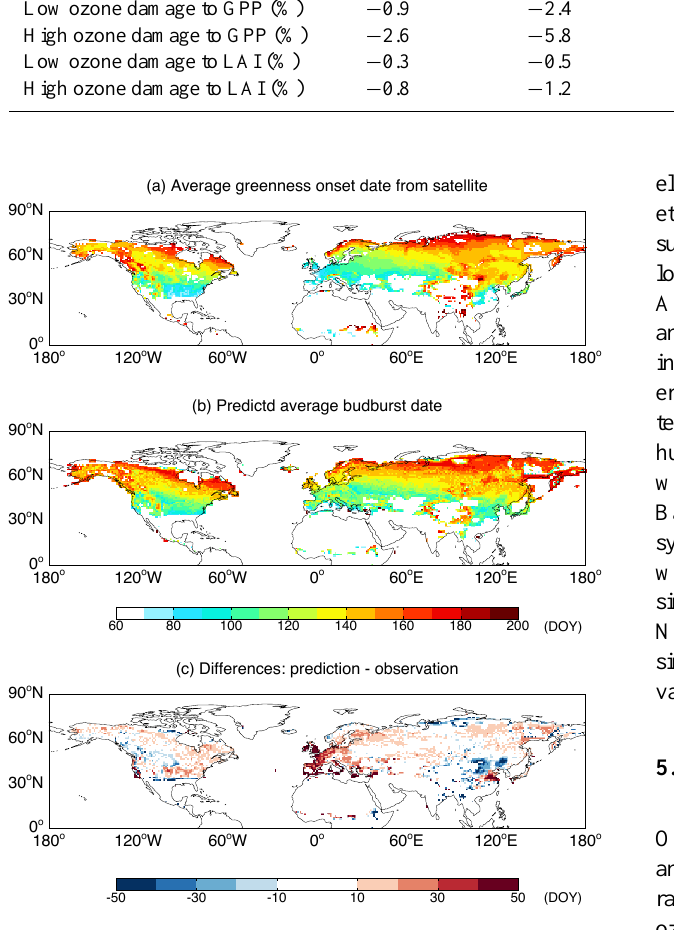
Figure 8. Comparison of simulated budburst dates in the North- ern Hemisphere with remote sensing. Simulated phenology in each grid square is the composite result from DBF, tundra, shrubland, and grassland based on PFT fraction and LAI in that grid box. Both sim- ulations and observations are averaged for the period 1982–2011. Results for the Southern Hemisphere are not shown due to the lim- ited coverage of deciduous forests and cold grass